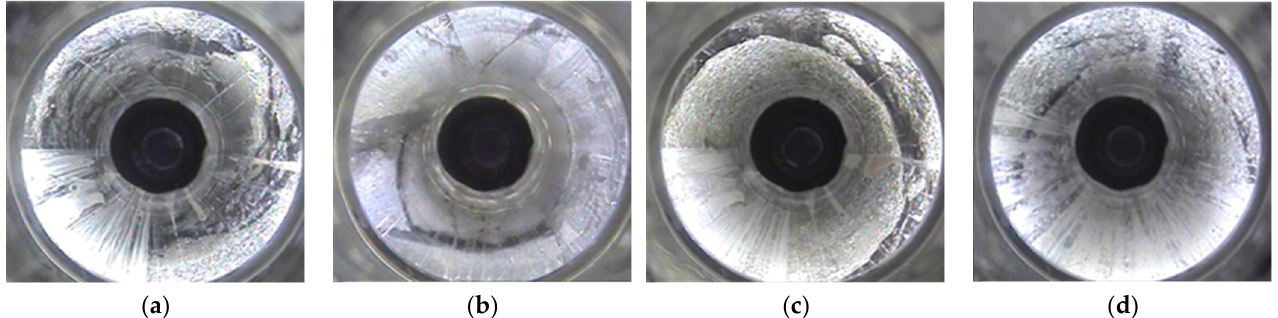
Figure 6. Crack distribution of the roof at a horizontal distance of 45.6 m from the working face: ( a ) Away from roadway roof: 0.6 m; ( b ) Away from roadway roof: 1.8 m; ( c ) Away from roadway roof: 2.8 m; ( d ) Away from roadway roof: 5 m.